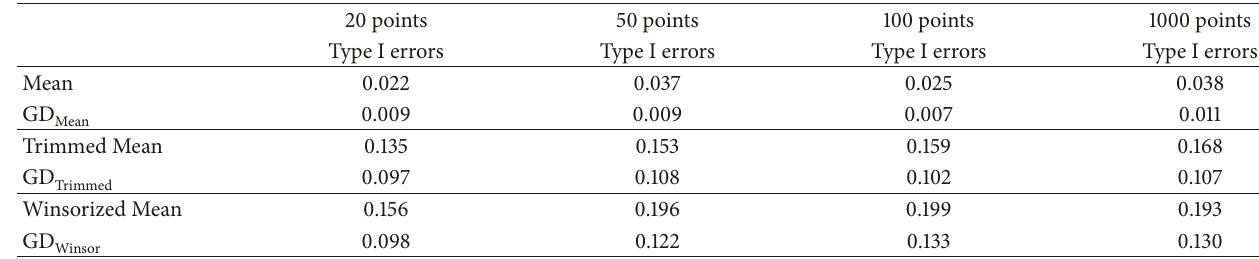
Table 20: Log-normal distributions with 50% noise